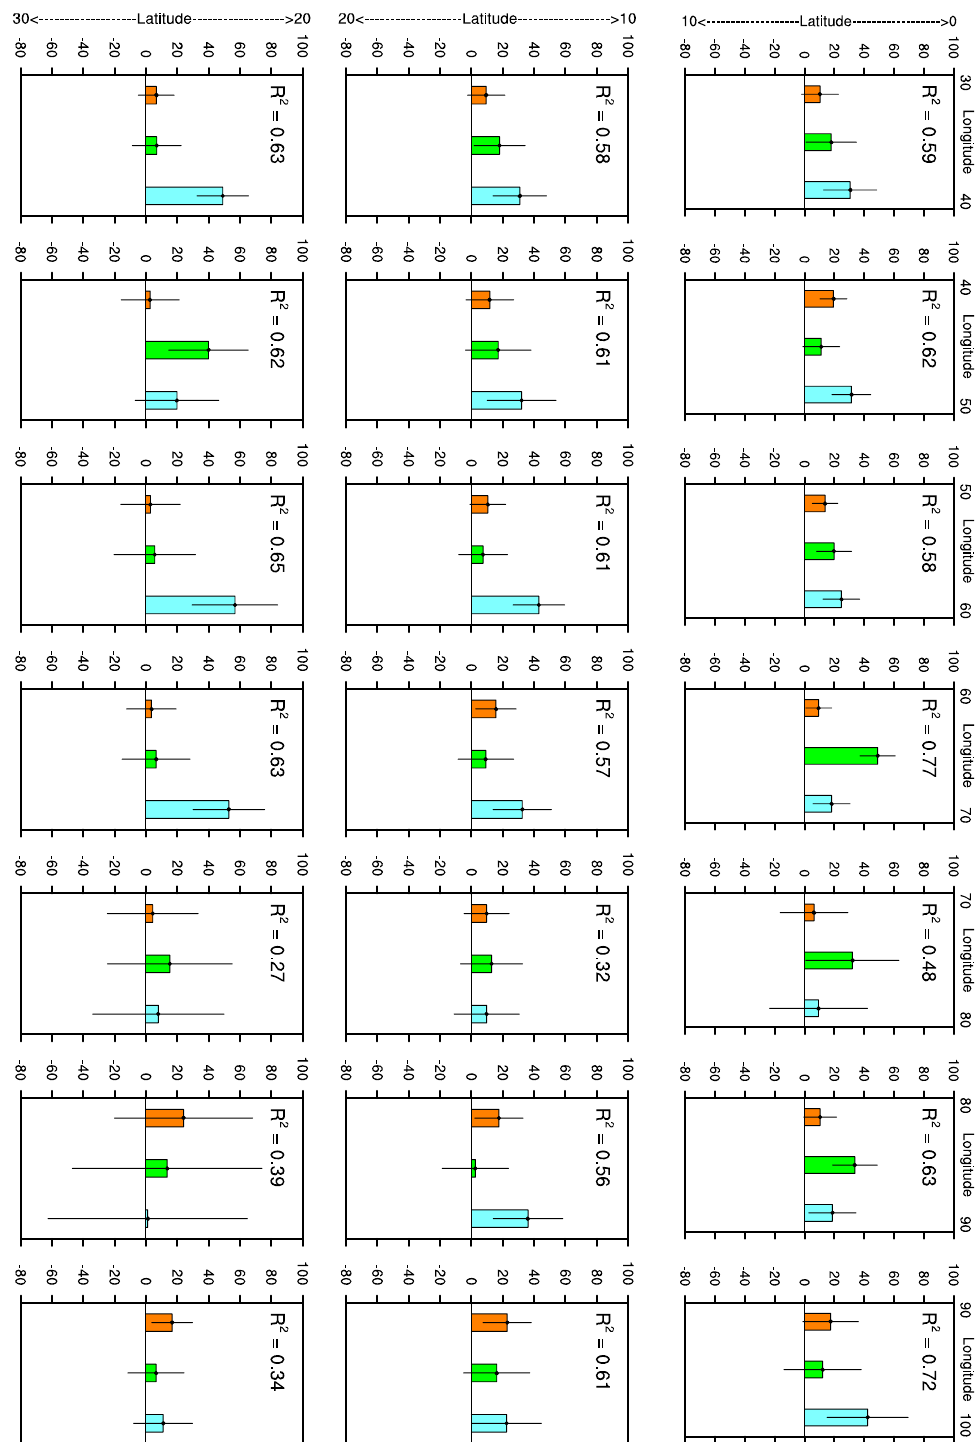
Fig. 6. Contributions (color boxes, in %) and standard deviations (black segments, in %) of the different forcings per 10 ◦ × 10 ◦ bin. Orange, green and blue bars represent the QBO, the IOD and the ENSO, respectively. The coefficients of determination ( R 2 ) are indicated on the top of each